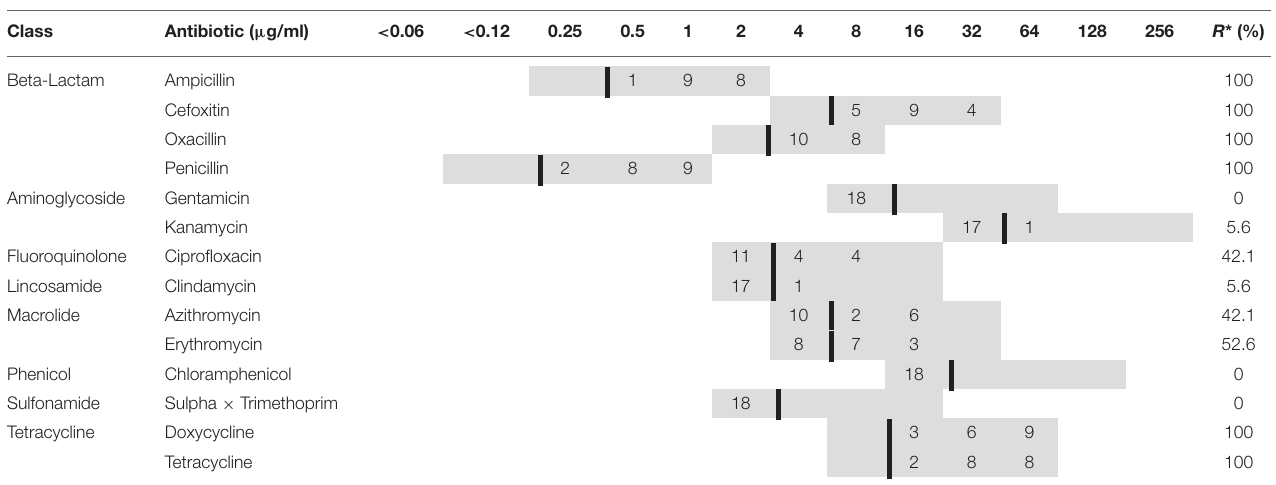
TABLE 1 | Antibiotic susceptibility testing of 18 S. aureus isolated from turkeys to 14 antimicrobial agents using agar gel diffusion test.